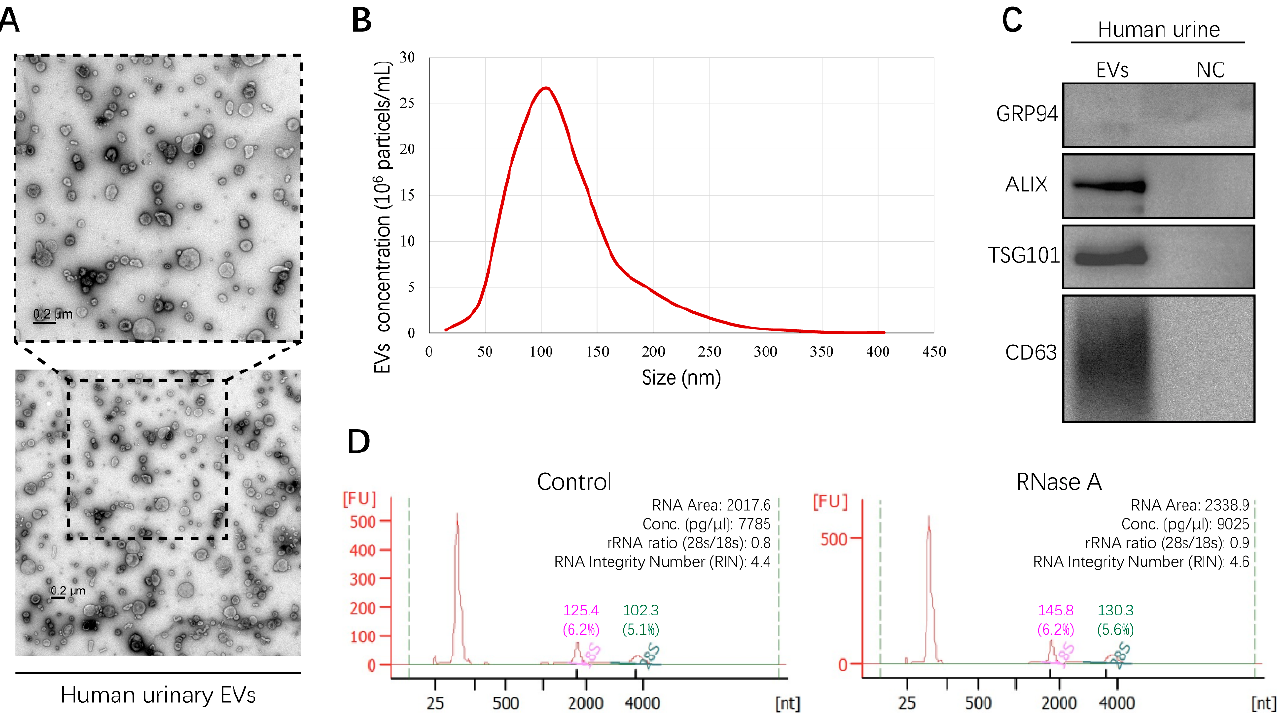
Figure 1. Characterization of human urinary extracellular vesicles (EVs). All experiments were performed as three independent experiments, and representative results were selected. ( A ) Transmission electron microscopy (TEM) images of EVs isolated from human urine sample (Scale bar, 200 nm). ( B ) The size and concentration of EVs were determined by nanoparticle tracking analysis (NTA). ( C ) Specific protein marker identification of EVs was conducted by Western blot analysis. Supernatants of last ultracentrifugation of each EVs sample were used as negative control (NC). ( D ) RNA landscapes of human urinary EVs with or without RNase A treatment were profiled by an Agilent 2100 Bioanalyzer. FU, fluorescence intensity. nt, RNA length in nucleotides. (Original Western blots see Figure S7).